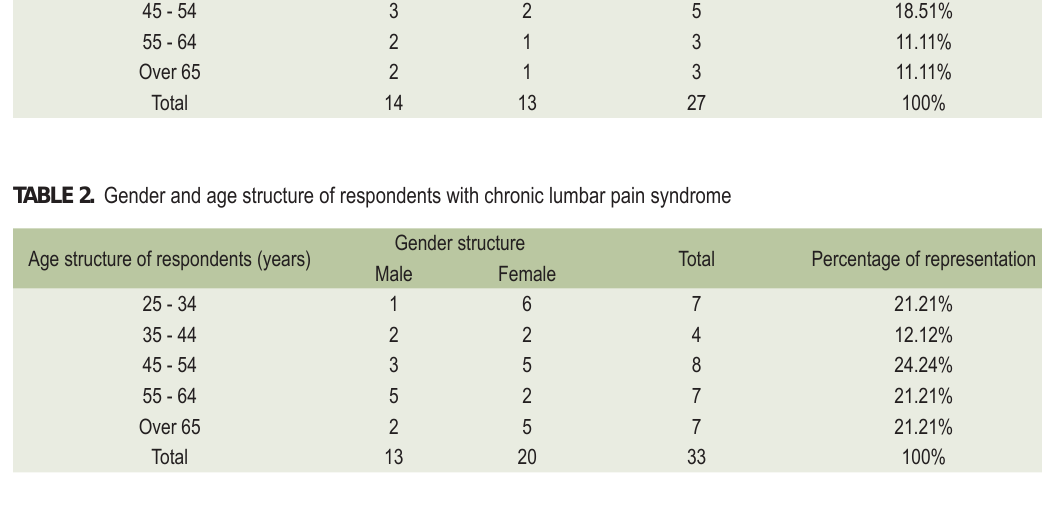
TABLE 3. Structure of the respondents according to occupa- TABLE 4. Structure of the respondents according to